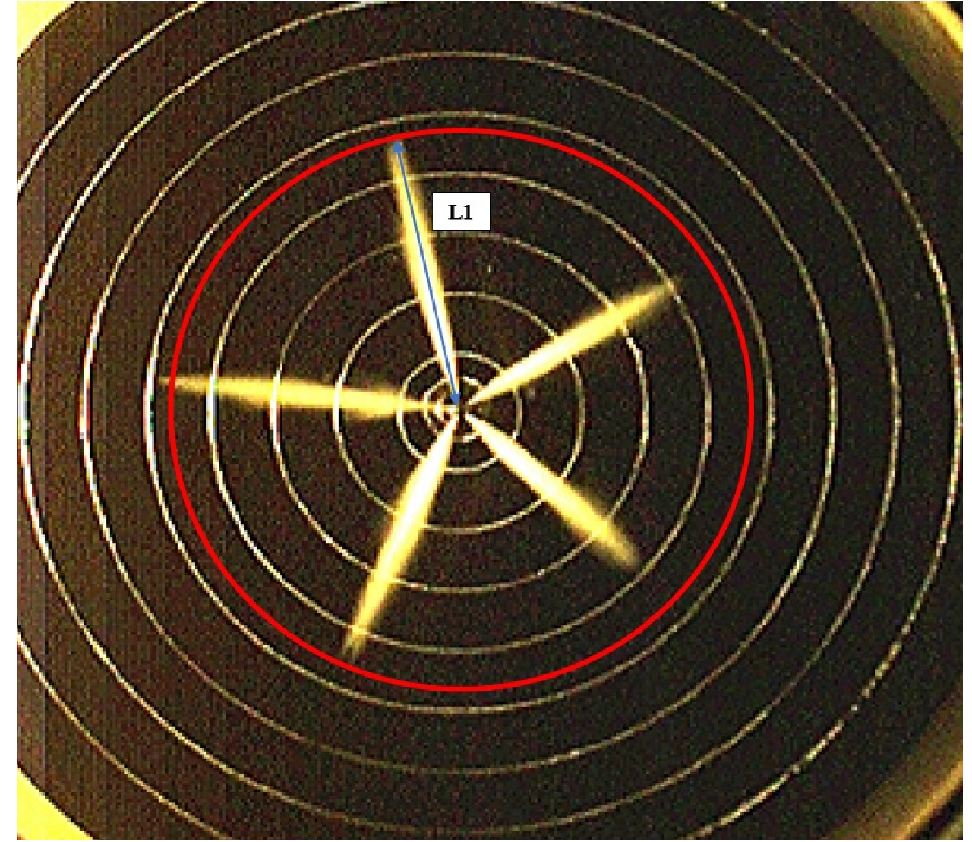
Figure 5. The method applied to measure the range of the first spray: L1—measured the range of the first spray.